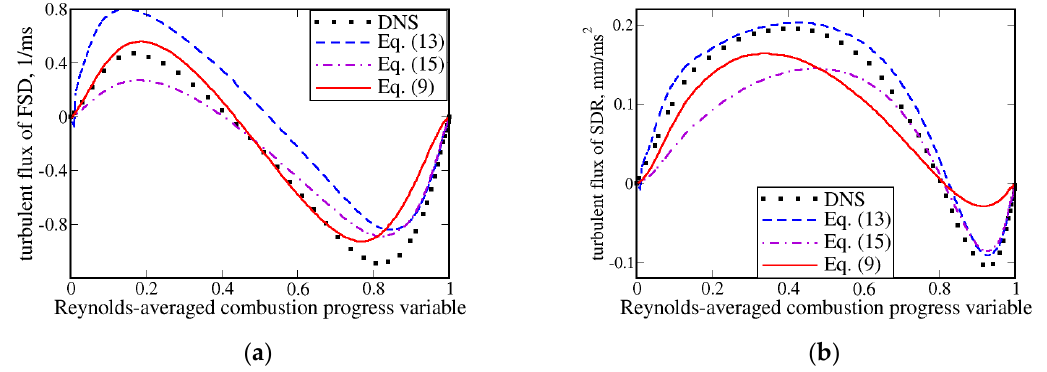
Figure 4. Turbulent axial fluxes of ( a ) FSD Σ and ( b ) SDR χ . Case H.